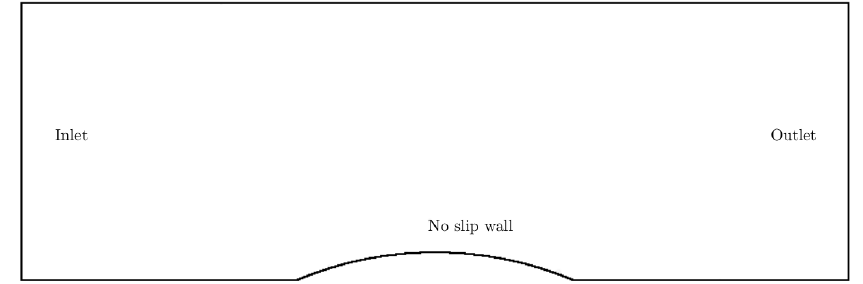
Figure 4. Transonic bump.